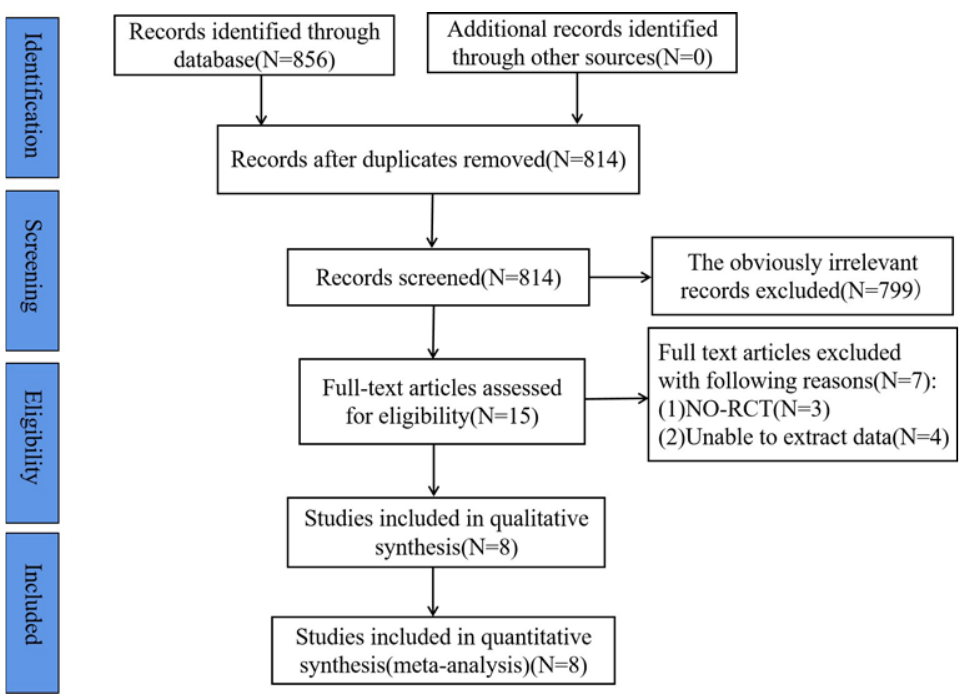
Figure 1. Flow chart of literature